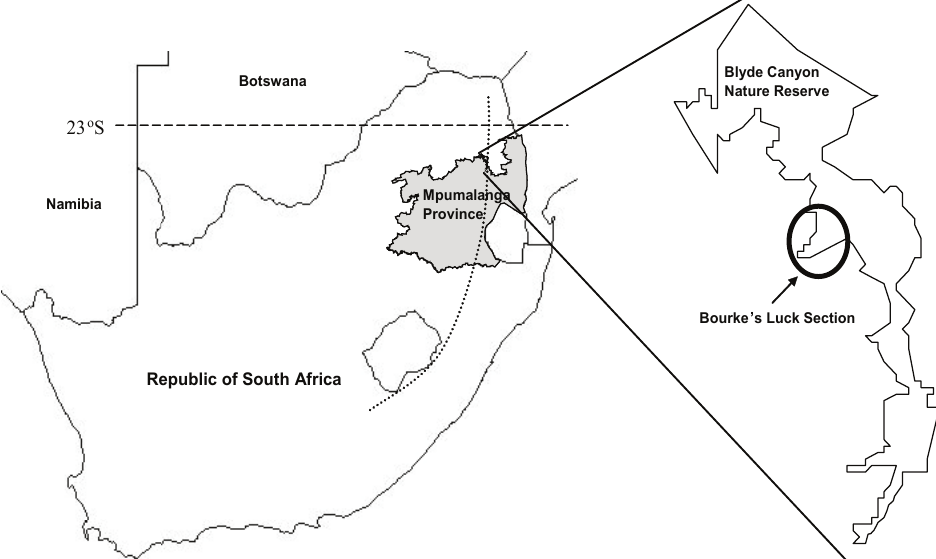
Fig. 1. A map of the study site’s location within South Africa and Mpumalanga Province (shaded). The dotted line indicates the approximate location of the Drakensberg